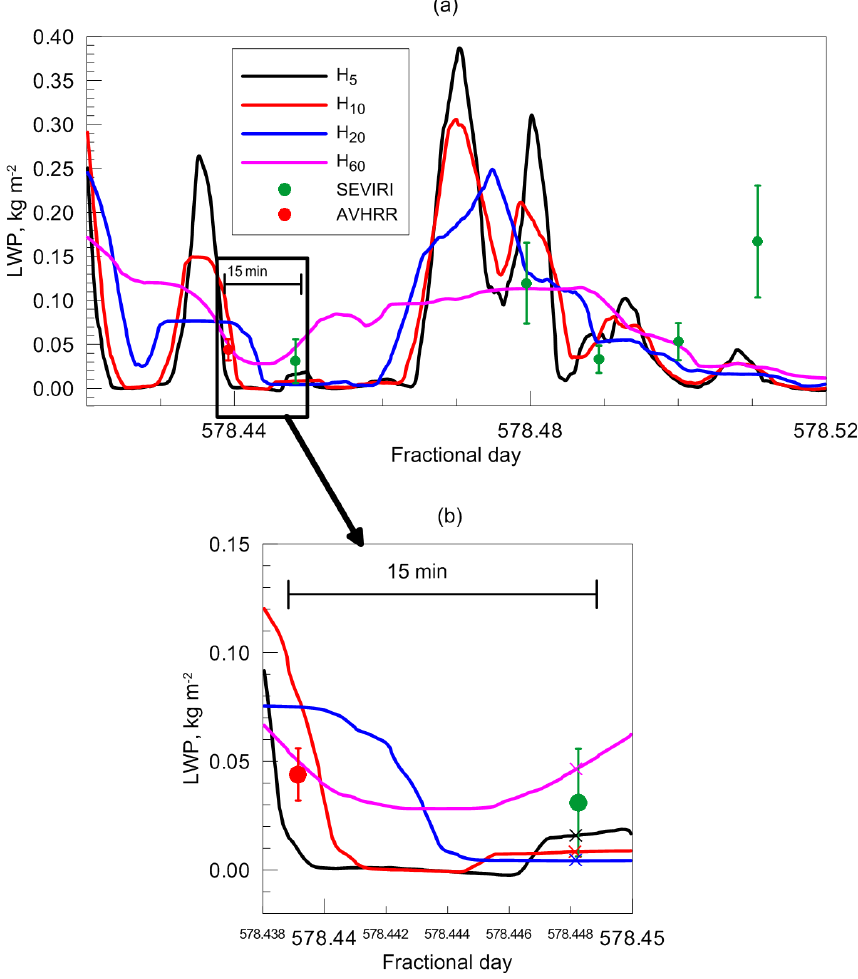
Figure 3. The HATPRO data flow presented in the form of running average values with different averaging intervals (colour lines; see the legend). The SEVIRI and the AVHRR instantaneous measurements are shown as green and red dots. The 2.5h interval of observations on 2 July 2014 is displayed in (a) . The 18min interval containing collocated SEVIRI and AVHRR measurements is magnified and is shown in (b) . The colour crosses designate the averaged HATPRO measurements, which are selected for comparison with the satellite